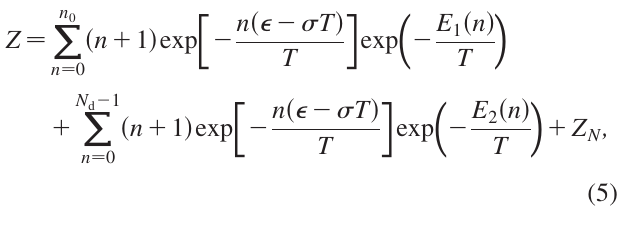
¼ 0 : 8 nm is the persistence length of ss DNA [27], the l s above energy being written in the quadratic